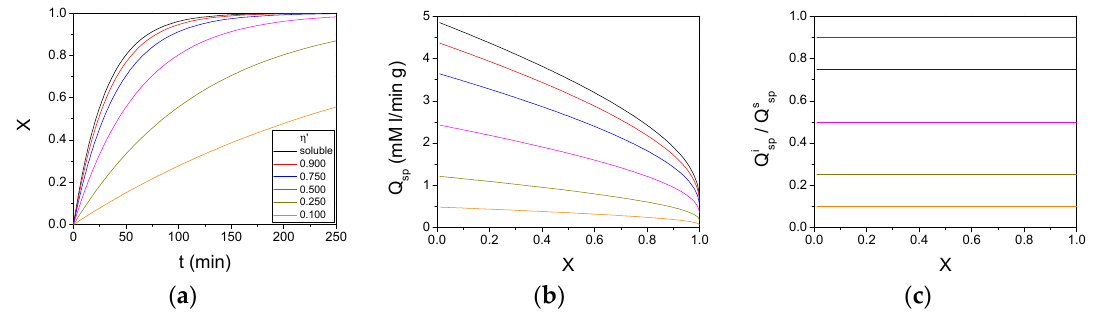
Figure 1. Plot series to calculate the EF from the reactor performance. Data for the hydrolysis of 150 mM lactose by soluble and immobilized β -galactosidase at 1 g/l ( E R ) and 35 °C. ( a ) Reaction progress with the effectiveness factor as a parameter; ( b ) volumetric productivity as a function of the conversion; ( c ) calculation of the mean integral EF according to Equation (15).